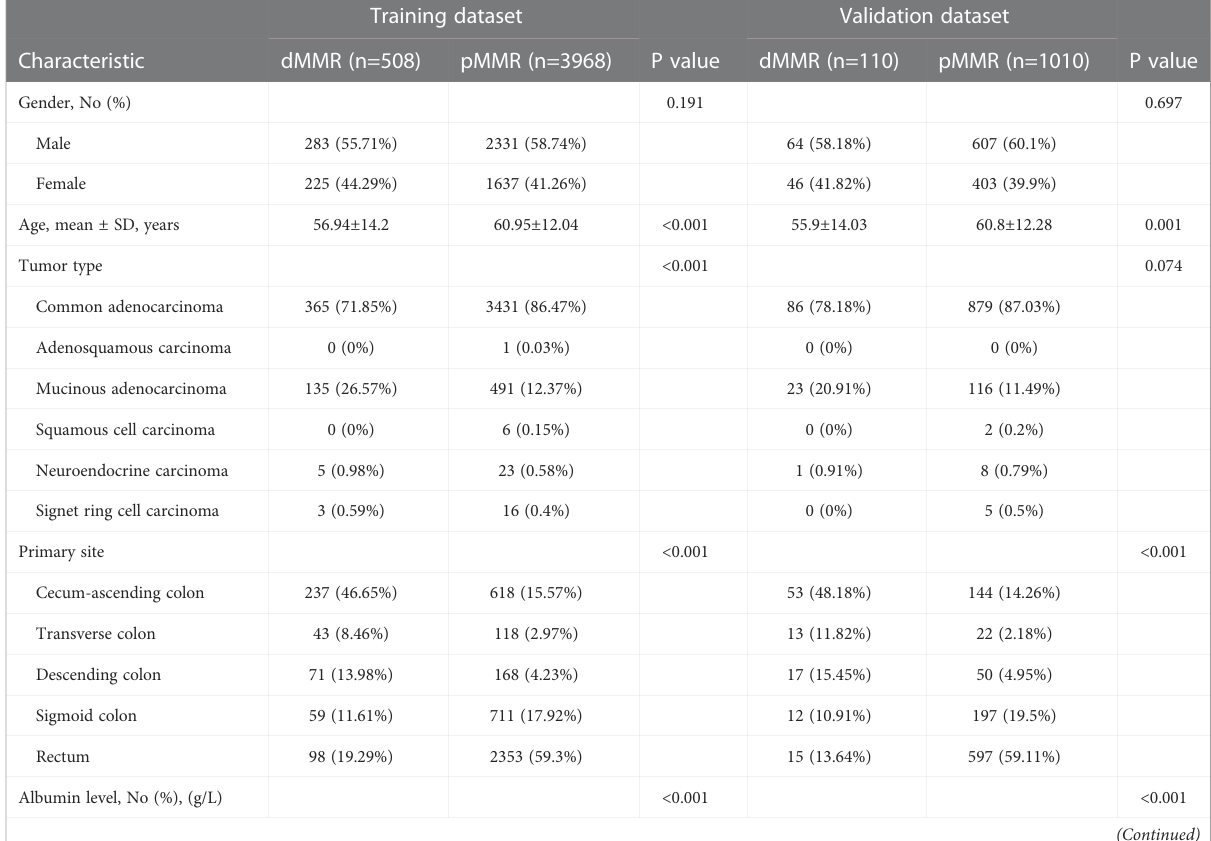
TABLE 2 Comparison of clinical characteristics in the dMMR and pMMR